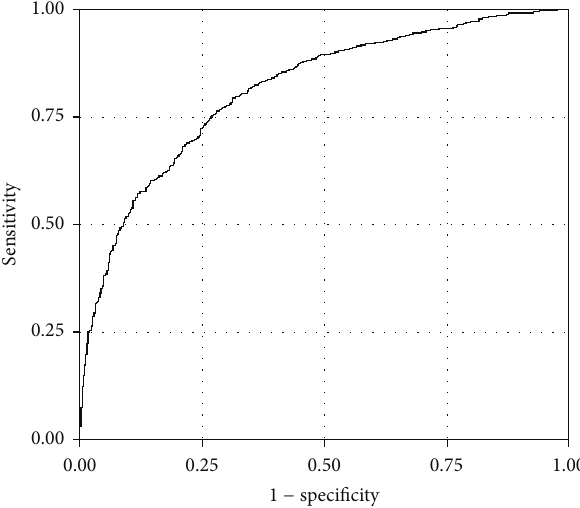
Figure2:Receiveroperatorcharacteristic(ROC)curveforaccuracy of final regression model for grade 0 versus grades 1, 2, and 3. The area under the curve was